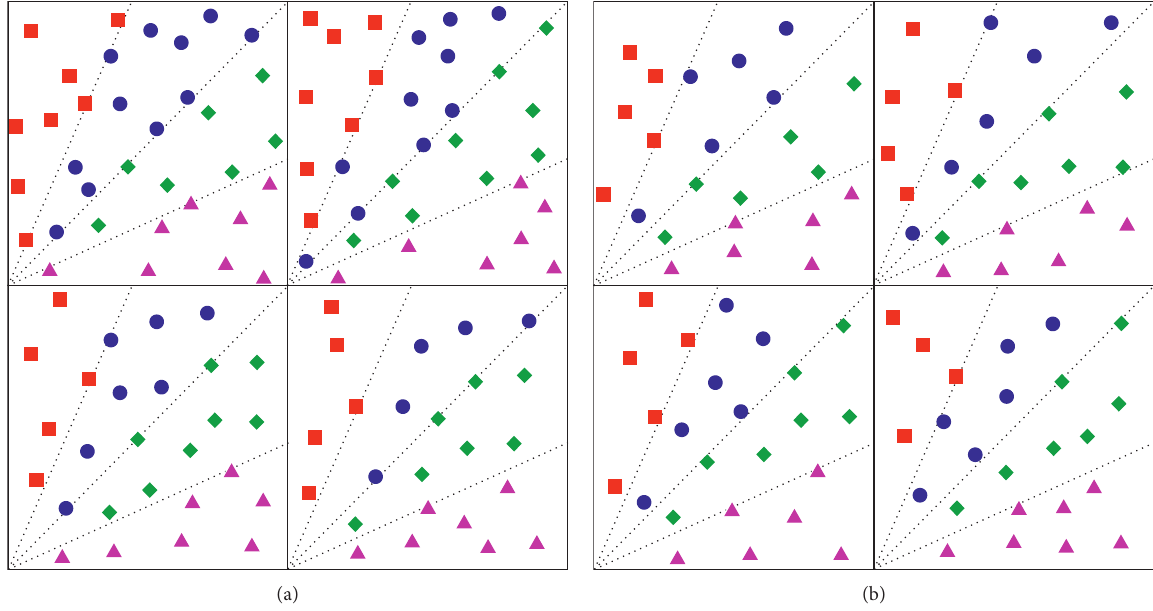
Figure 2: Rating results of training data (a) and test data (b) in the optimal model parameter selection. Note: rectangle: height; circle: friction angle; diamond: slope angle; triangle: cohesion; the three dotted lines are probability dividing lines with 25%, 50%, and 75% probability clockwise in each